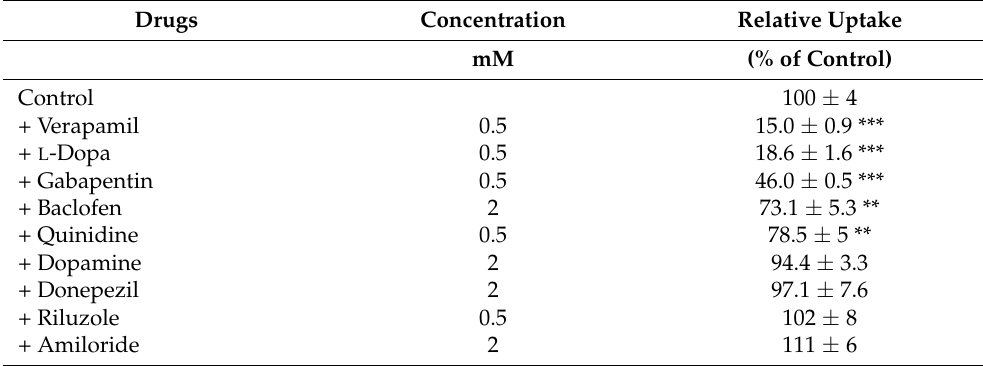
Table 4. Effect of selected pharmacological drugs on [ 3 H] L -tryptophan uptake by TR-BBB cell lines.